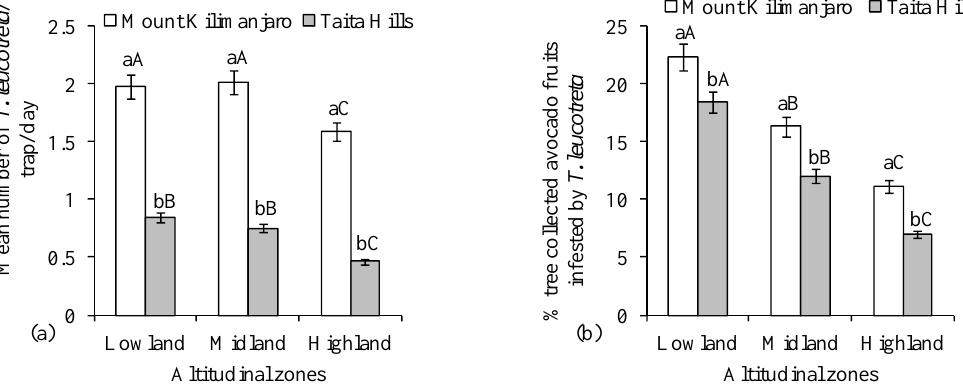
Figure 4. ( a ) Number of Thaumatotibia leucotreta (Mean ± SE) along agro-ecological zones of Taita Hills and Mount Kilimanjaro transects and ( b ) percent infestation of avocado fruits picked from the tree by Thaumatotibia leucotreta . Bars capped with the same lowercase letters within the same altitudinal zone are not significantly different, while bars capped with similar uppercase letters for the same transect are not significantly different.